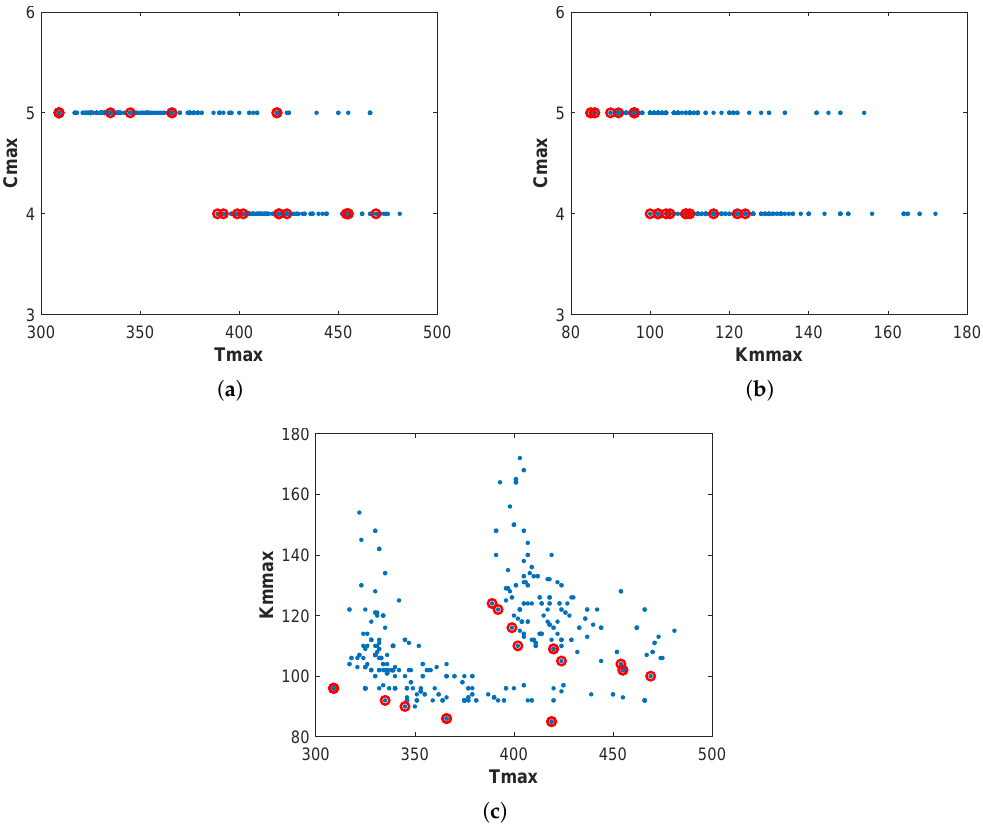
Figure 6. 2D Projections of the multi-objective Pareto front.